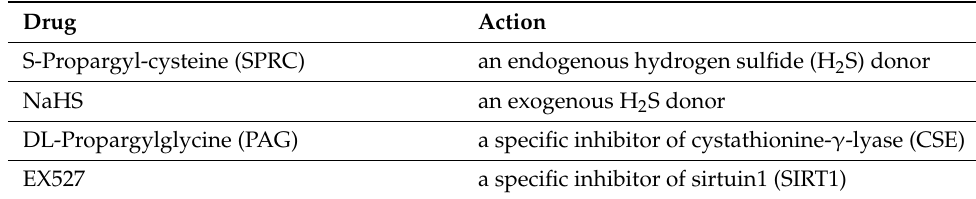
Table 1. List of the drug actions used in this